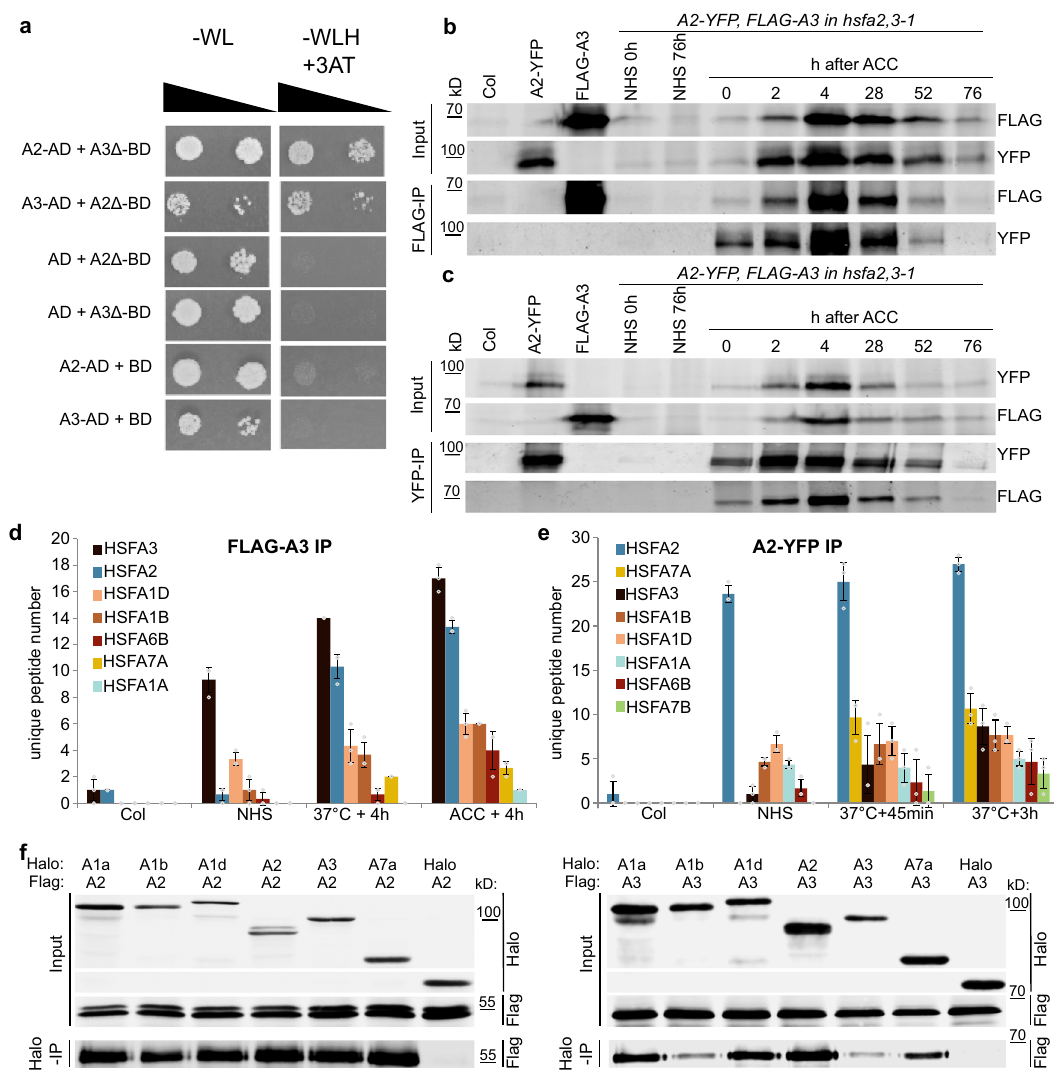
Fig. 7 HSFA2 and HSFA3 form protein complexes during HS memory. a HSFA2 and HSFA3 interact in the yeast-two-hybrid assay. The C-terminal trans- activating domains of HSFA2 and HSFA3 were deleted (A2 Δ aa 1-269, A3 Δ aa 1-275) when fused to the GAL4-DNA-binding domain (BD) to prevent auto activation. Serial dilutions were grown on – WL medium (not selecting for interaction) or on – WLH medium supplemented with 50 mM 3-AT to check for protein-protein interactions. b , c HSFA2 and HSFA3 interact in planta as shown by co-immunoprecipitation experiments: transgenic lines carrying both pHSFA2::HSFA2-YFP and pHSFA3::FLAG-HSFA3 constructs in the hsfa2 hsfa3-1 double mutant background were subjected to an ACC treatment and samples were taken at the indicated time points. Immunoprecipitation of FLAG-HSFA3 yielded the HSFA2-YFP protein ( b ) and immunoprecipitation of HSFA2-YFP yielded the FLAG-HSFA3 protein ( c ) at all time points examined. No bands of similar size were co-puri fi ed in non-treated plants (NHS 0 h and NHS 76 h), single transgenic lines or Col plants sampled at 4 h after ACC. A representative experiment from 3 independent experiments is shown. d , e Interacting HSF proteins as identi fi ed by co-immunoprecipitation of FLAG-HSFA3 ( d ) or HSFA2-YFP ( e ) followed by mass spectrometry after the indicated treatments (37 °C treatment was for 1 h). Average numbers of unique peptides are given for all HSF proteins identi fi ed (cf. Supplementary Table 2). Data are mean ± SD of three independent experiments. Note that the HSF proteins are sorted according to the number of peptides recovered and this differs for HSFA2- and HSFA3-co-puri fi ed proteins, the same color code is used in ( d ) and ( e ). f In vitro pulldown of HSFA proteins. Pairs of the indicated Halo-tagged and FLAG- tagged HSF proteins were co-translated in vitro and puri fi ed with anti-Halo beads. The Halo-tag alone was used as a negative control. A representative experiment from 3 independent experiments is